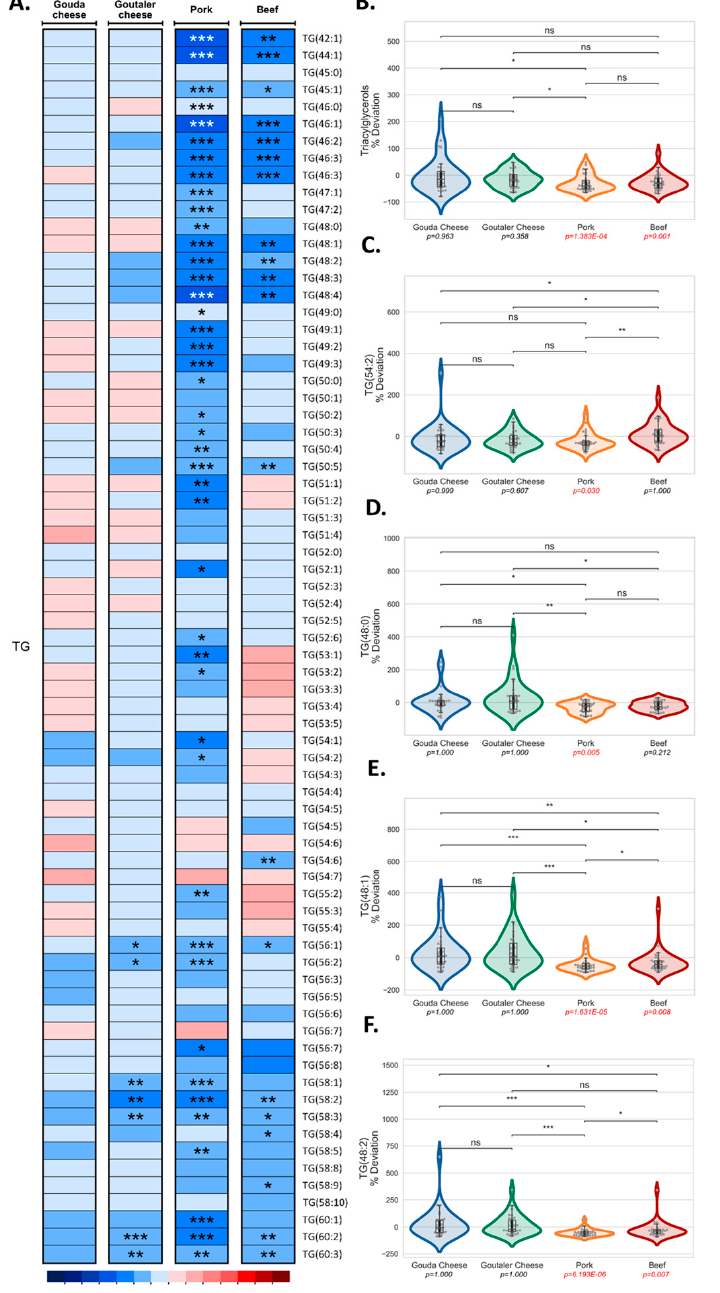
Figure 3. Heatmap representing the results (median ± SD of the percentage of change post- versus pre-intervention values) of the triglycerides from the lipidomic analysis for the four test diets (Gouda- and Goutaler-type cheeses, pork, and beef) ( A ), TG class ( B ) and TG species 54:2 ( C ), 48:0 ( D ), 48:1 ( E ), and 48:2 ( F ) comparisons between test diets.